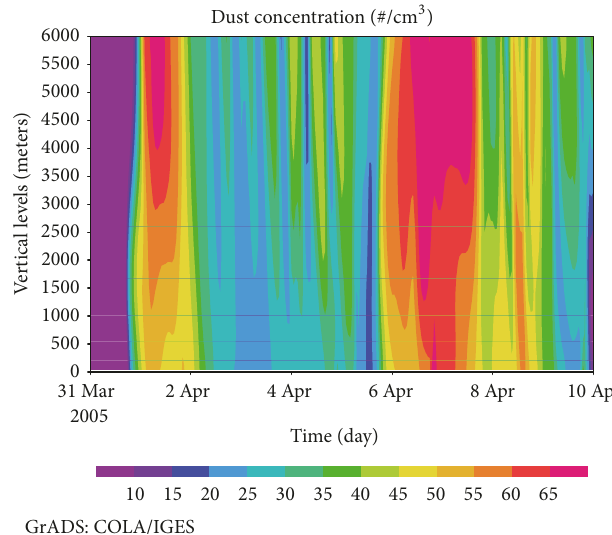
Figure 9: Daily average dust concentration profile for a1d1 for Case Study 2.